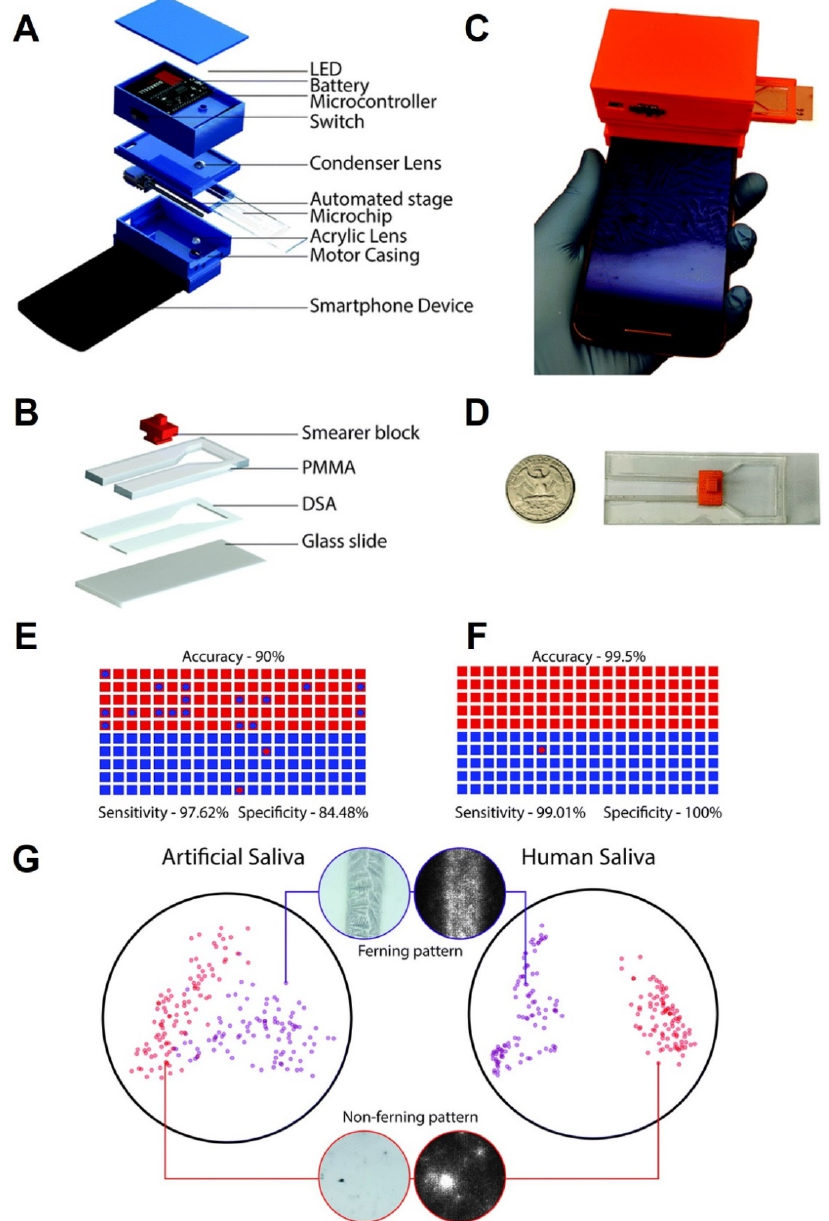
Figure 5. Schematic of the cellphone-based imaging system and reusable microfluidic kit and the system output also with a t-SNE representation with human and artificial saliva samples. (A) The view of the autonomous (wireless) optical device and its parts. (B) The photograph of the manufactured autonomous imaging method using a smartphone for fern structure imaging and evaluation in naturally dried saliva specimens. (C) The schematic of the tool with a holding box. (D) A real microfluidic system put near a quarter-coin of US. (E) The scatter plot demonstrates the performance of the system in assessing samples of naturally dried unreal saliva ( n = 200). (F) The scatter plot displays the performance of the system when assessing samples of naturally dried human saliva. The rectangles portray true marks, and the circles are the categorization of the scheme. (G) The scatter diagram serves to illustrate the distinction of ovulating and non-ovulating types depending on the fern structures shown by the naturally dried human and artificial saliva. Reproduced with permission from [118].